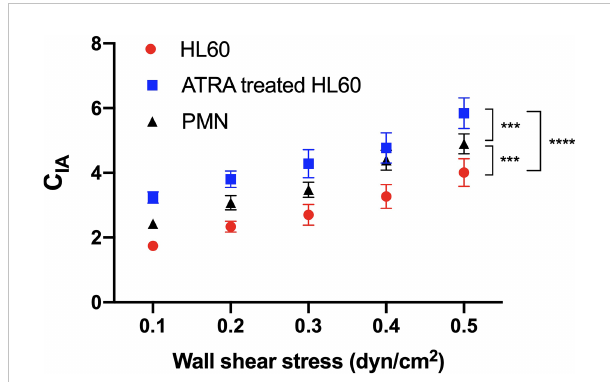
FIGURE 6 Variation of the activation coef fi cient of b 2 integrin on rolling cells versus wall shear stress. Neutrophils (black) and untreated (red) or all-trans retinoic acid (ATRA)-treated (1 × 10 -6 M, 120 h) Hl60 cells (blue) were rolled on immobilized P-selectin combined with ICAM- 1. C IA , the integrin activation coef fi cient, was evaluated by C IA = 10 7 ×| ä |/ g , where g was the acceleration of gravity and ä was the absolute value of the cell roll acceleration ( ä ). The data were shown as mean ± SEM and represented by at least 100 events from three independent experiments. Statistical signi fi cance was analyzed by two-way ANOVA followed by Tukey ’ s multiple-comparisons tests, and the signi fi cant level of difference was shown by the P -value. *** P < 0.001, **** P <